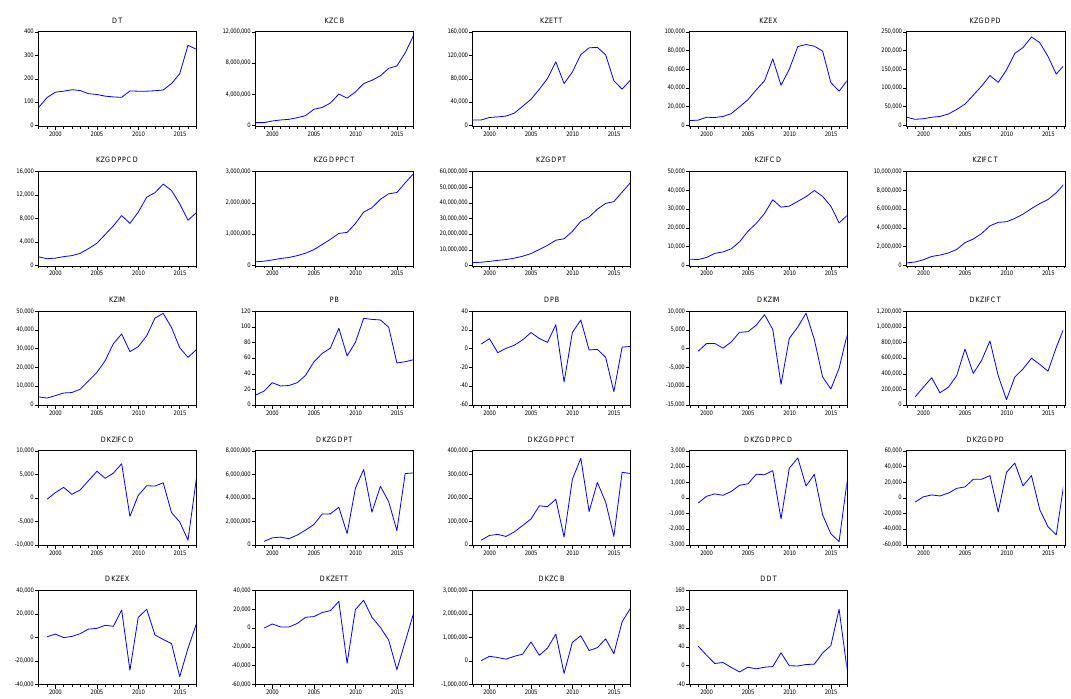
Figure A5. Macroeconomic indicators of Kazakhstan